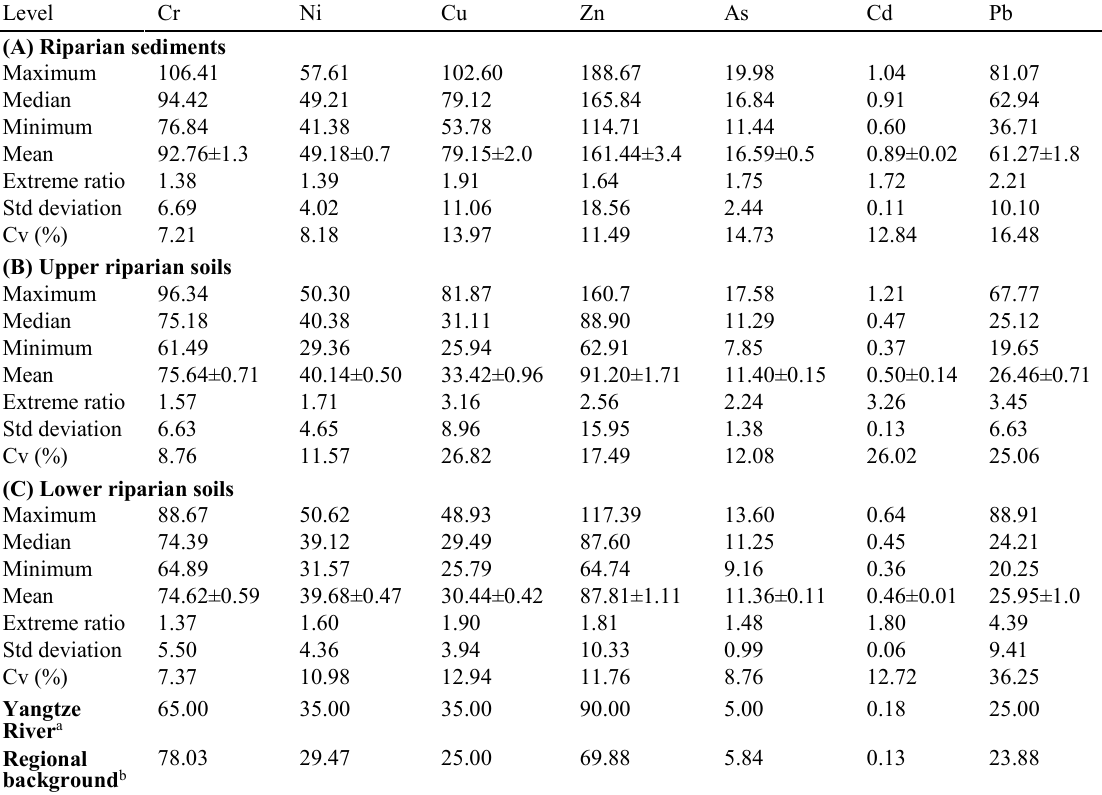
Table 1 Heavy metal contents (mg/kg) in the riparian sediments, upper riparian soils (0–5 cm) and lower riparian soils (5–10 cm).